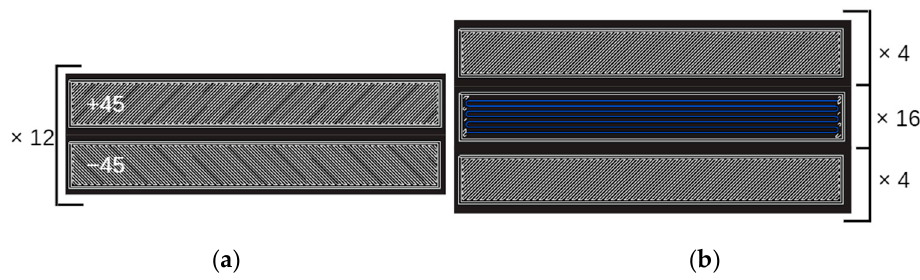
Figure 5. DMA sample details: ( a ) ONYX sample architecture—24 layers of 0.125 mm thickness (alternating layers of ± 45 ONYX); ( b ) continuous carbon-fiber-reinforced ONYX sample architecture (blue—carbon filament reinforcement, white—ONYX matrix).